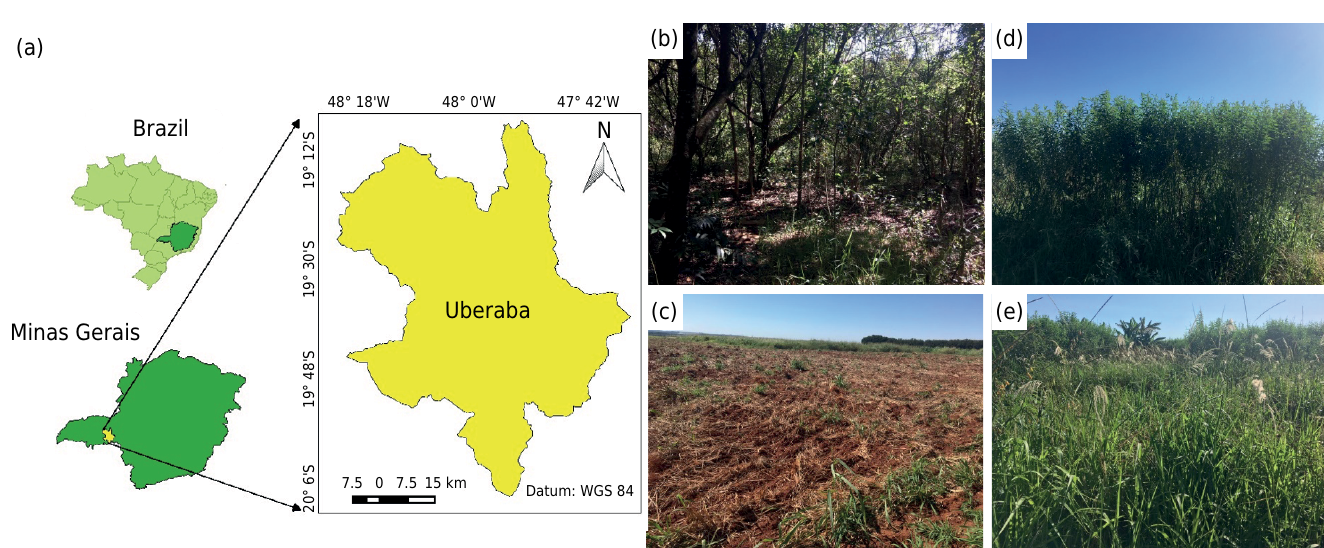
Figure 1. Location of the municipality of Uberaba, Minas Gerais, Brazil (a). Field photographs of the reference site (b), a well-preserved area in the Brazilian Cerrado without any history of wood extraction; 20-year conventional tillage site (c); 6-year no-till site with Crotalaria as cover crop (d); 18-year no-till site with Brachiaria as cover crop